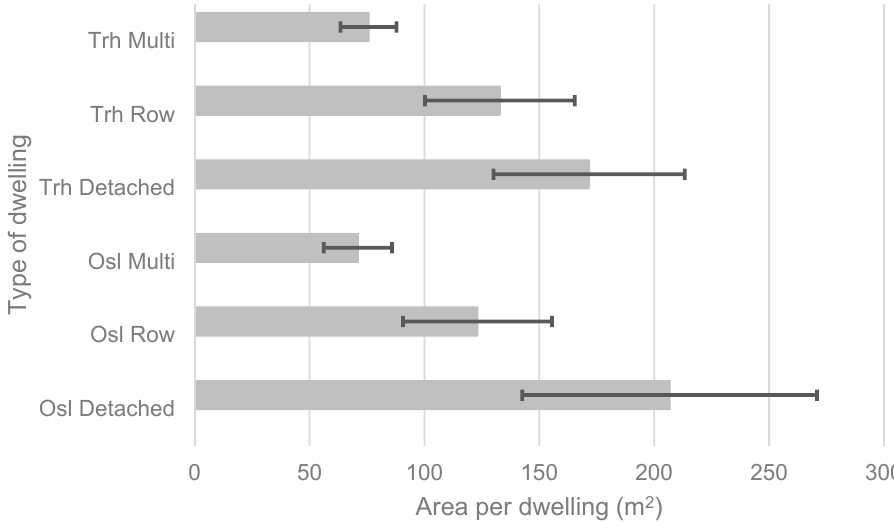
Figure 5. Dwelling types and floor areas (mean and standard deviation) in Oslo and Trondheim.